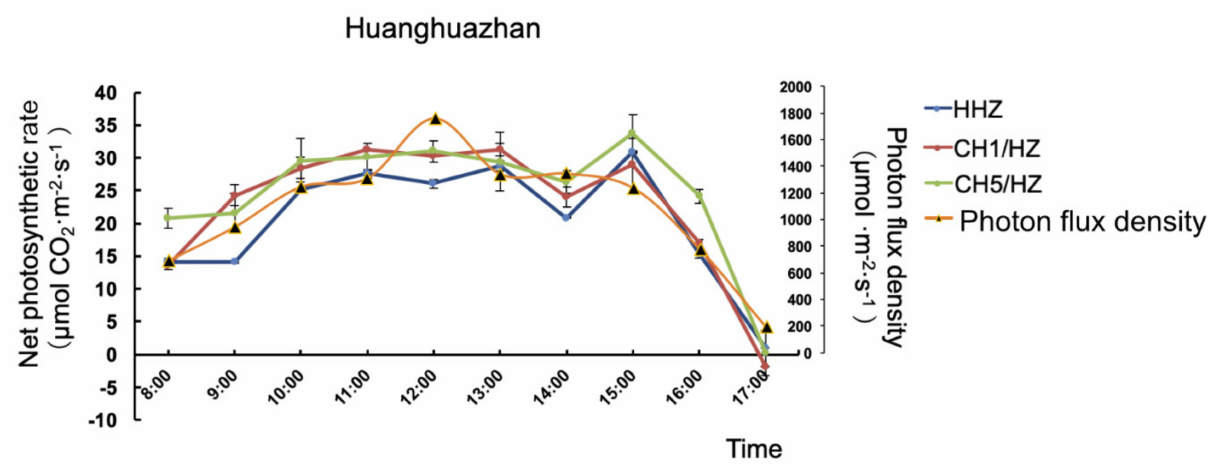
Figure 6. Diurnal curves of the Pn of HHZ, CH1/HZ, and CH5/HZ plants. Diurnal curves of the Pn of the HHZ, CH1/HZ, and CH5/HZ plants in June in Guangzhou, China (temperature range of 28~36 ◦ C under normal air conditions (CO 2 concentration of approximately 400 mmol · mol − 1 , relative humidity of 50~75%)), were generated. Data shown are the means ±